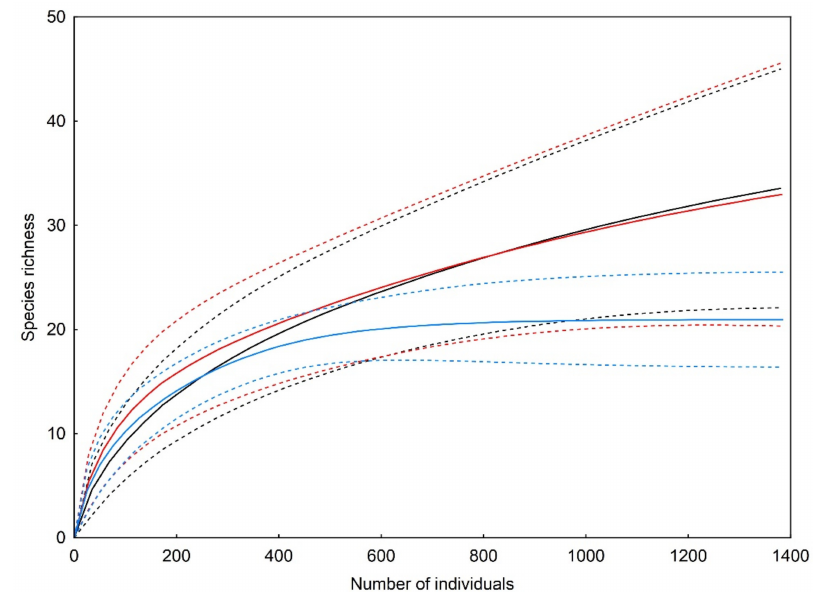
Figure 5. Individual-based rarefaction (solid) curves with 95% confidence limits (dashed curves) comparing species richness of trunk-dwelling spider assemblages in three developmental phases of primeval oak–lime–hornbeam forest: the optimal phase (black), terminal phase (red) and regeneration phase (blue).